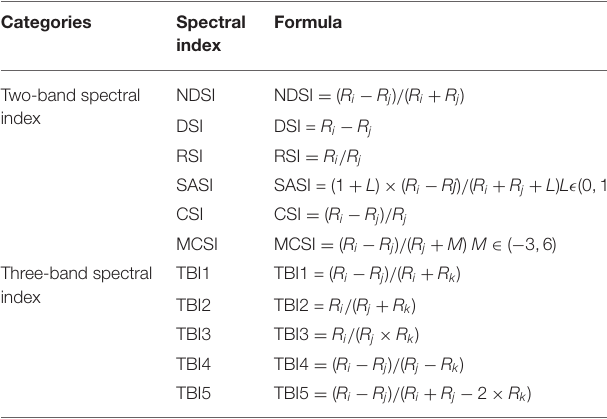
TABLE 1 | The formulae of selected two-band and three-band spectral index in this